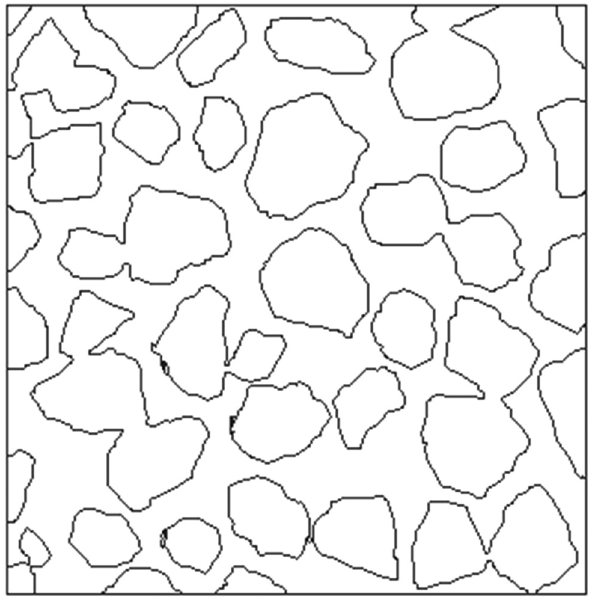
Figure 7: Outline of sand in particle group state.